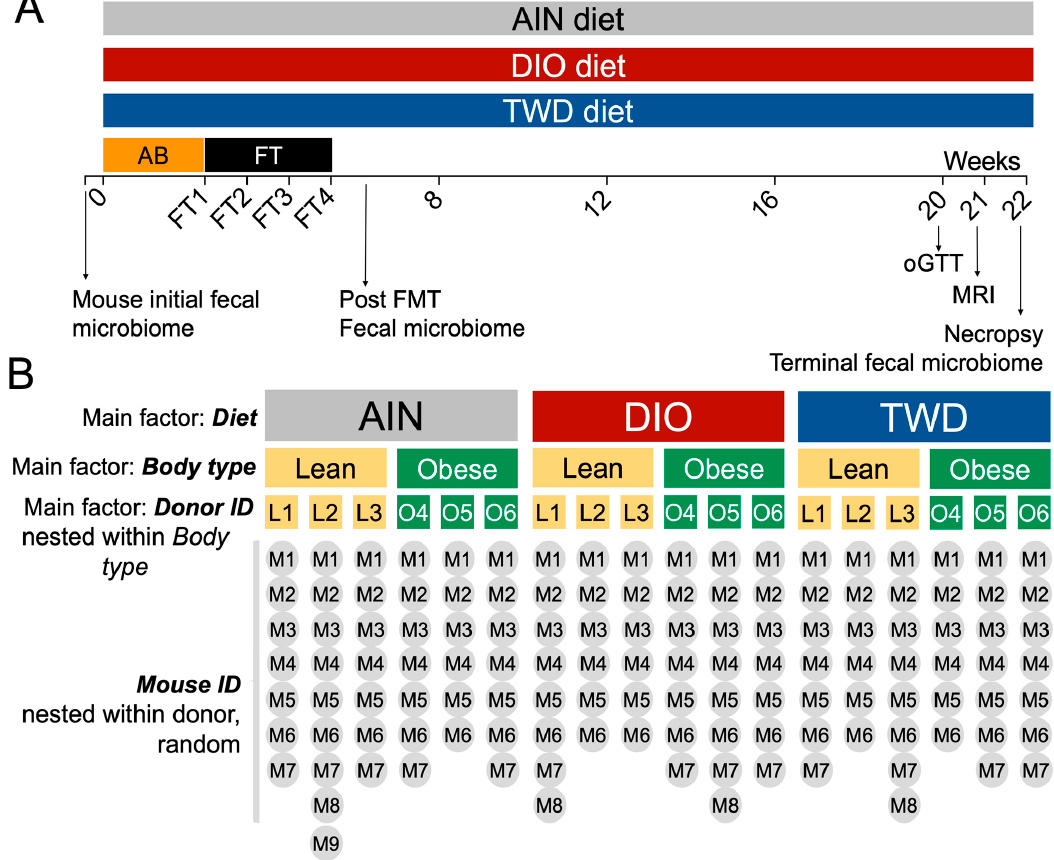
Figure 1. Experiment design and allocation of mice to experimental diets and human donor groups. ( A ) Experiment timeline indicating the timing of antibiotic treatment (AB), fecal transfer from human donors, experimental diets, collection of fecal material for microbiome sequencing and other endpoints. ( B ) Experiment design, including main factors included in the basal diet (AIN93G (AIN), diet-induced obesity (DIO), or total Western diet (TWD)), body type (lean or obese), and human donor ID (L1, L2, L3, O4, O5, O6) nested within the body type. Mouse ID is a random factor nested within both donor and body type.